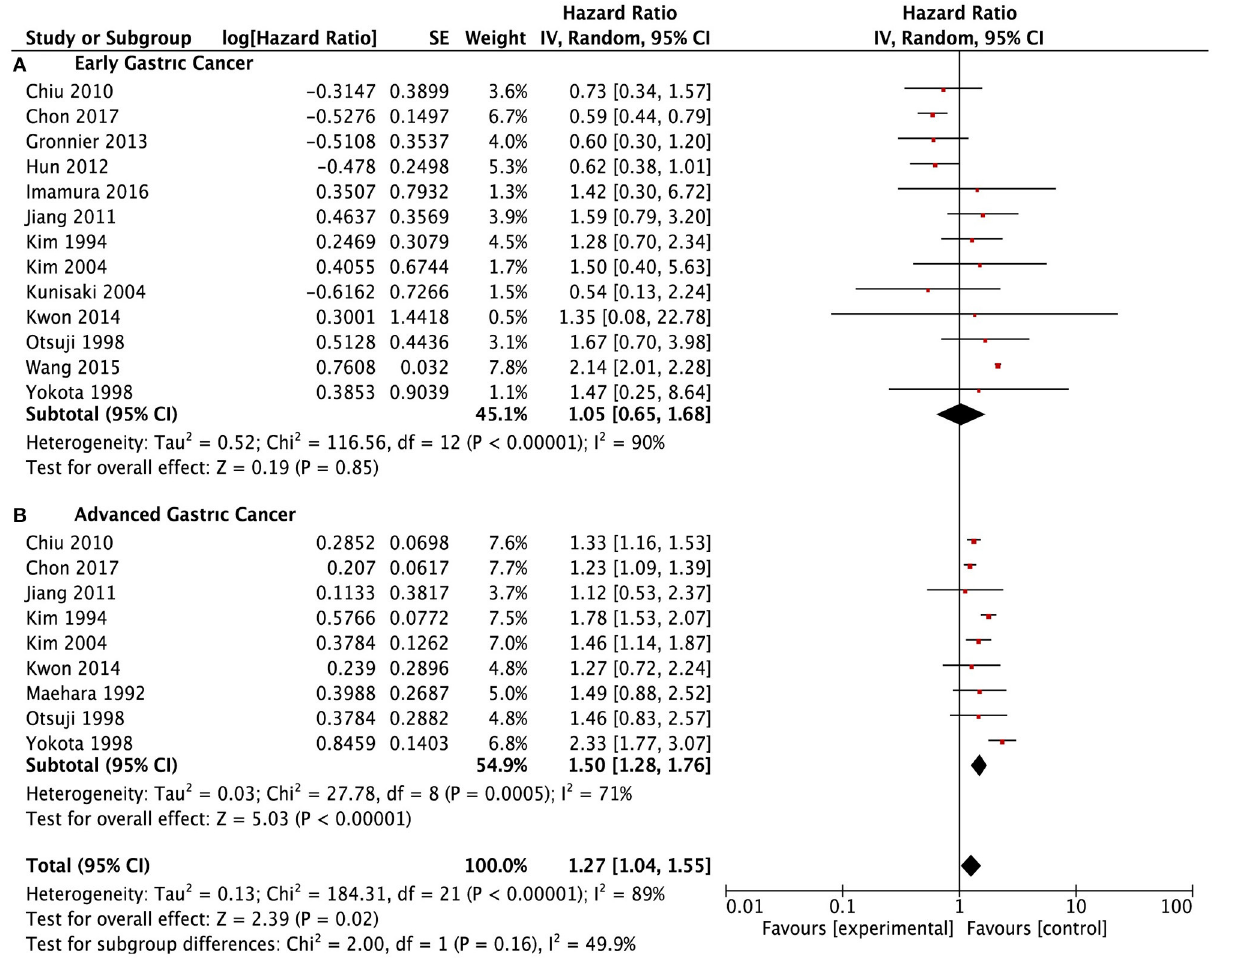
of those 36 studies included are presented in Table 1 .